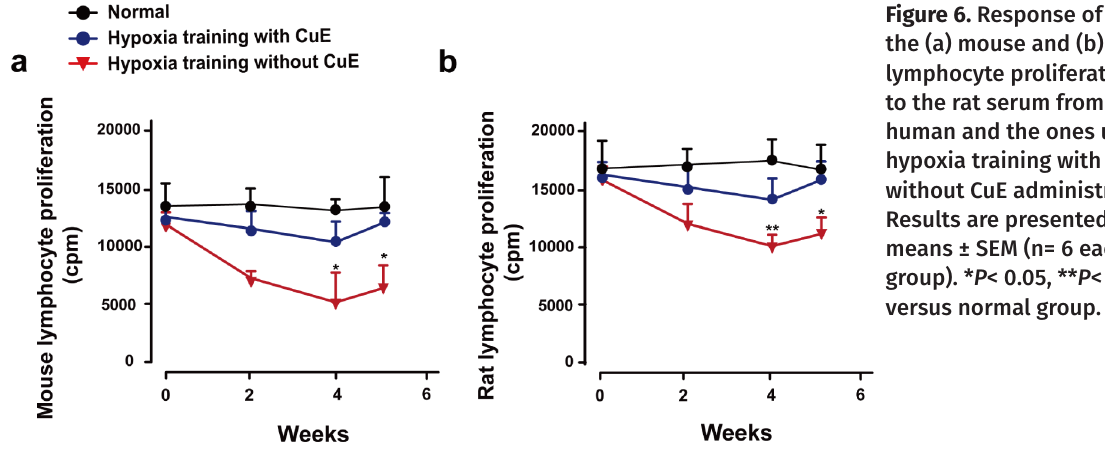
Figure 6. Response of the (a) mouse and (b) rat lymphocyte proliferation to the rat serum from the human and the ones under hypoxia training with or without CuE administration. Results are presented as means ± SEM (n= 6 each group). * P < 0.05, ** P < 0.02 versus normal